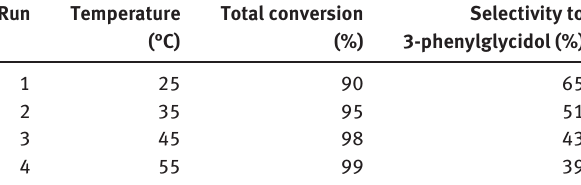
Table 4 Epoxidation reaction of cinnamyl alcohol in